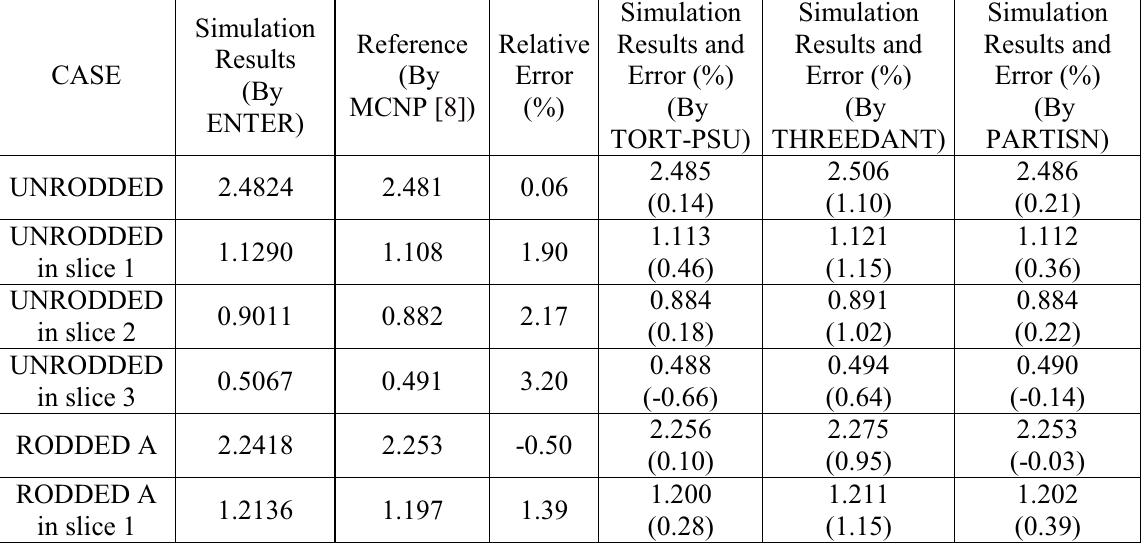
Table I: Results of Maximum Pin